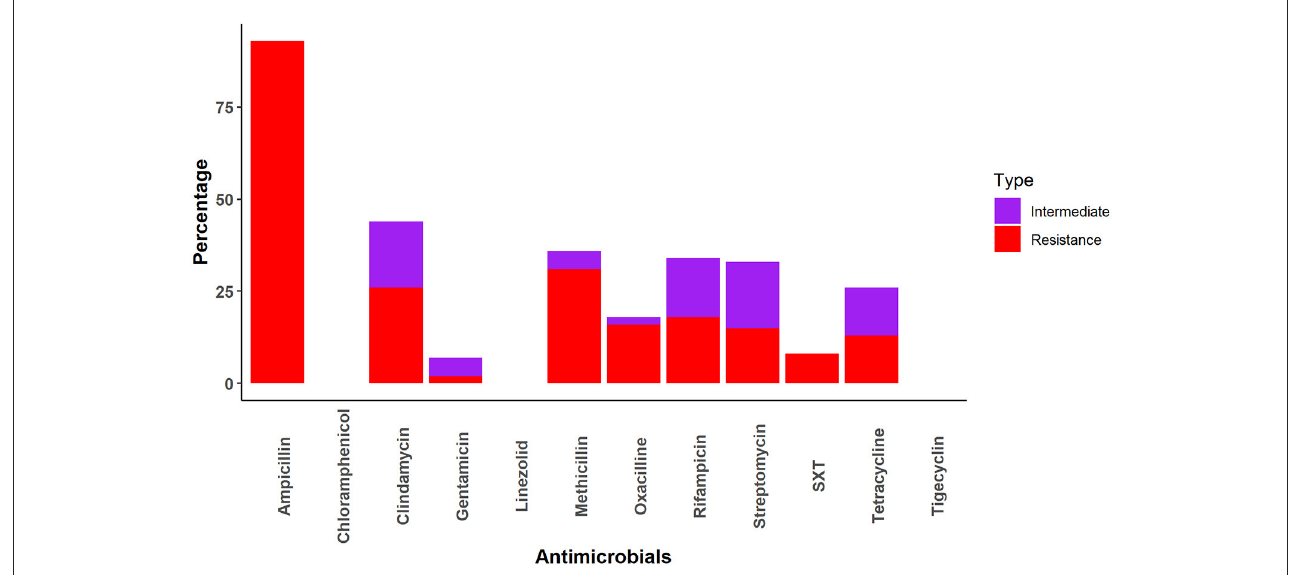
FIGURE3 AMR patterns of Staphylococcus